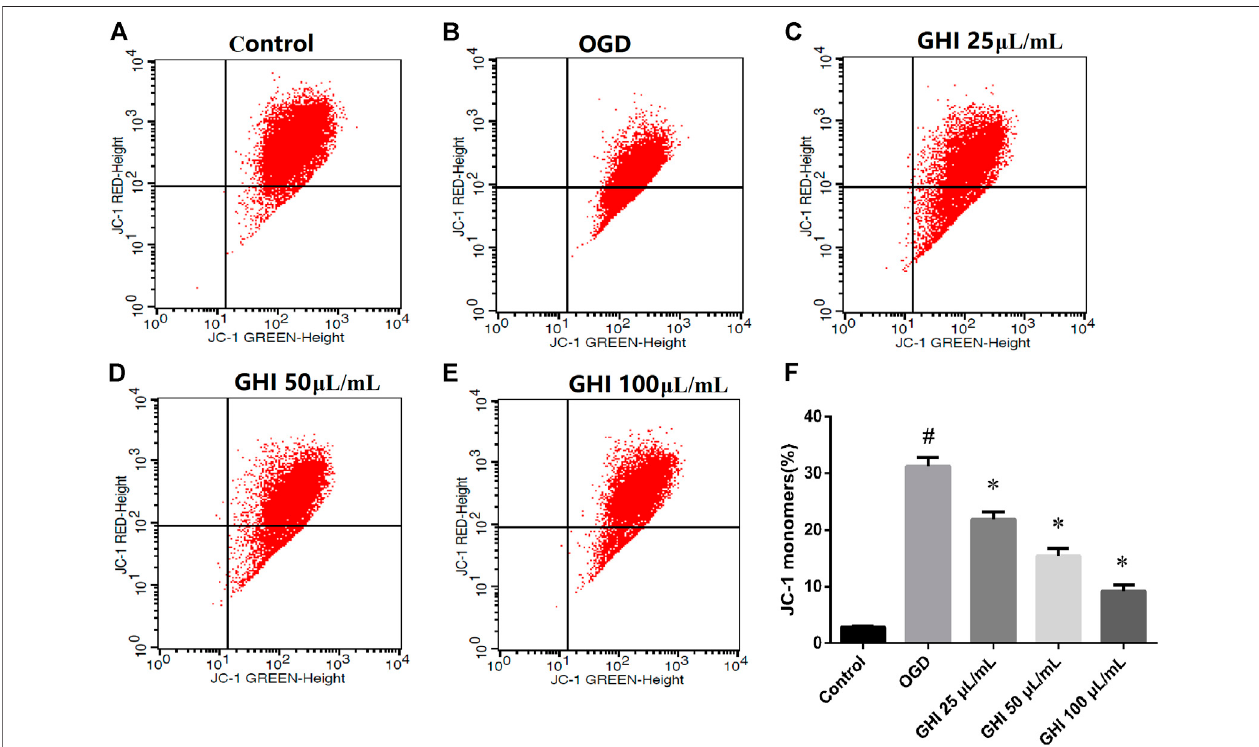
FIGURE 11 | GHI treatment decreases the proportion of the JC-1 monomer of rBMECs under OGD injury (n (cid:2) 3). (A – E) Flow cytometry images and (F) statistical analysis of JC-1. # p < 0.01 compared with the control group; * p < 0.01 compared with the OGD